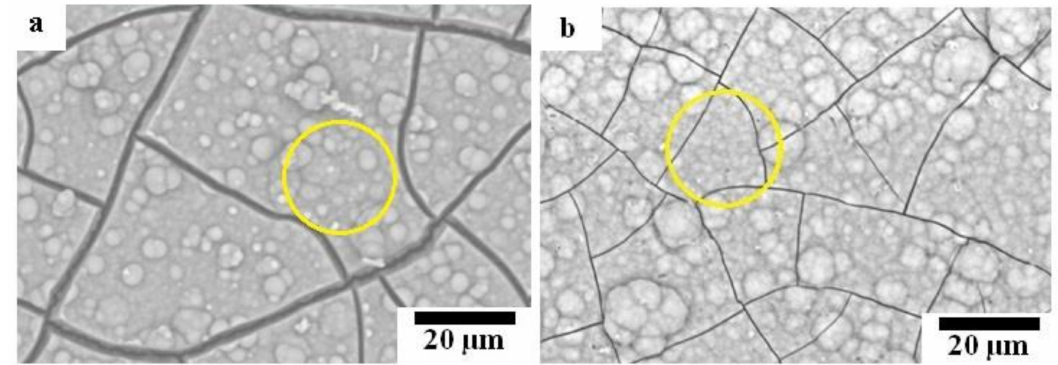
Figure 9. SEM micrographs of HAp-coated composites after 14 days of immersion: ( a ) immersed HAp-coated Mg-10ZnO-10 min, ( b ) immersed HAp-coated Mg-10ZnO-2.5 h + 10